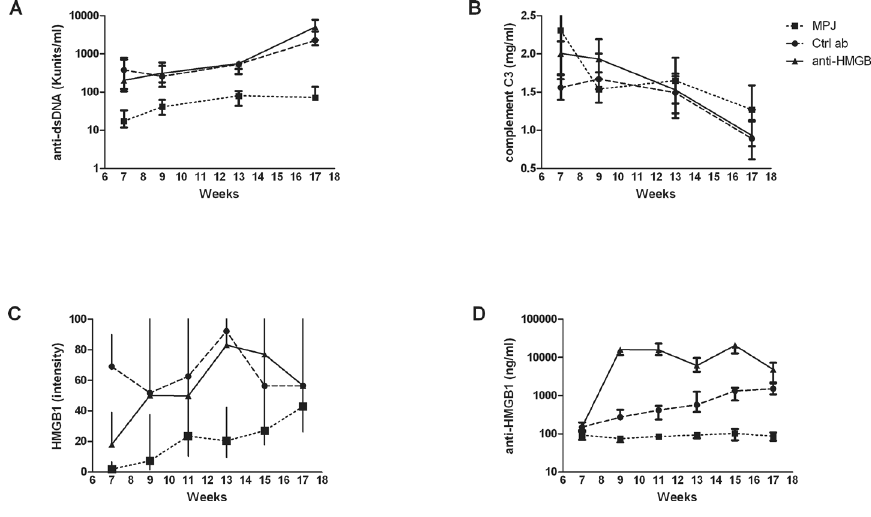
Figure 2. Anti-HMGB1 mAb treatment of MRL/lpr mice does not affect plasma levels of HMGB1, anti-dsDNA antibodies and complement C3, while increasing HMGB1 antibody levels. (A) Plasma anti-dsDNA (units/mL) was measured by ELISA in MRL/MPJ (n = 10) and MRL/lpr (n = 10–12) mice at wks 7, 9, 13 and 17. (B) Plasma complement C3 (mg/mL) was measured by ELISA in MRL/MPJ (n = 10) and MRL/lpr (n = 10–12) mice at wk 7, 9, 13 and 17. (C) Plasma HMGB1 was measured by Western blotting in MRL/MPJ (n = 10) and MRL/lpr (n = 10–12) mice at wks 7, 9, 11, 13, 15 and 17. HMGB1 levels are presented as